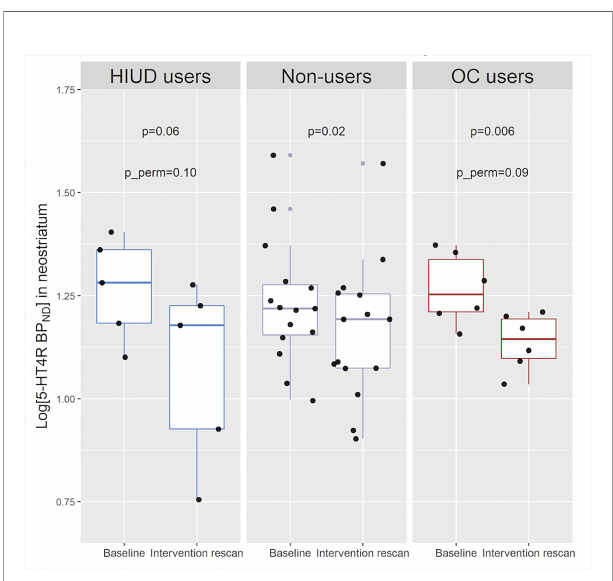
FIGURE 5 | The effect of eight weeks of SSRI/SNRI treatment on neostriatal 5-HT4R binding across the groups. p_perm: p-values based on 10,000 permutations to account for the small sample sizes in the oral contractive (OC)- and the hormonal intrauterine device (HIUD) user